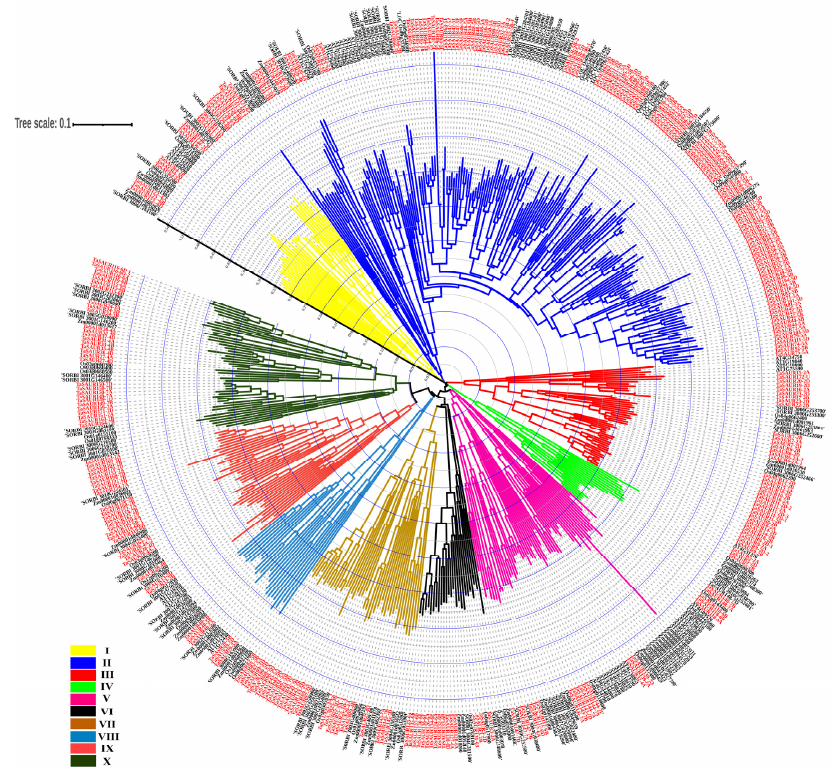
Figure 1. Phylogenetic analysis of SAURs homolog proteins in five different plant species. The phylogenetic tree was generated with MEGA 7.0, using the neighbor-joining (NJ) algorithm. The accession numbers of SAURs proteins in Oryza sativa , Zea mays , Arabidopsis thaliana , Sorghum bicolor , and Triticum aestivum (red font) are listed in Supplementary Table S2. Ten major clades are distinguished with different colors.